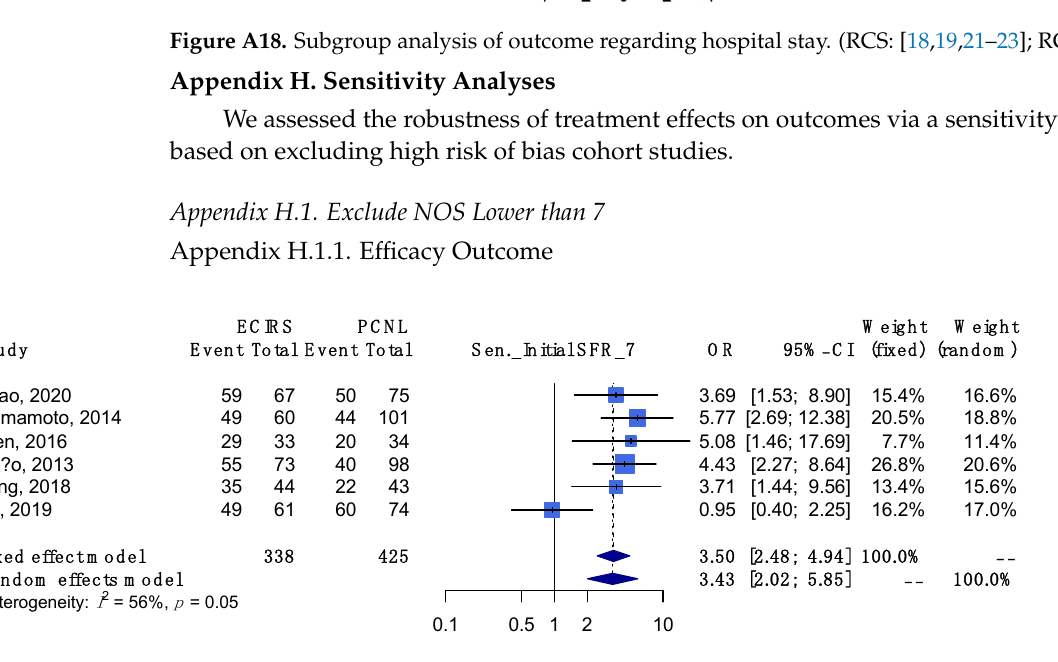
Figure A18. Subgroup analysis of outcome regarding hospital stay. (RCS: [18,19,21–23]; RCT: [17]).